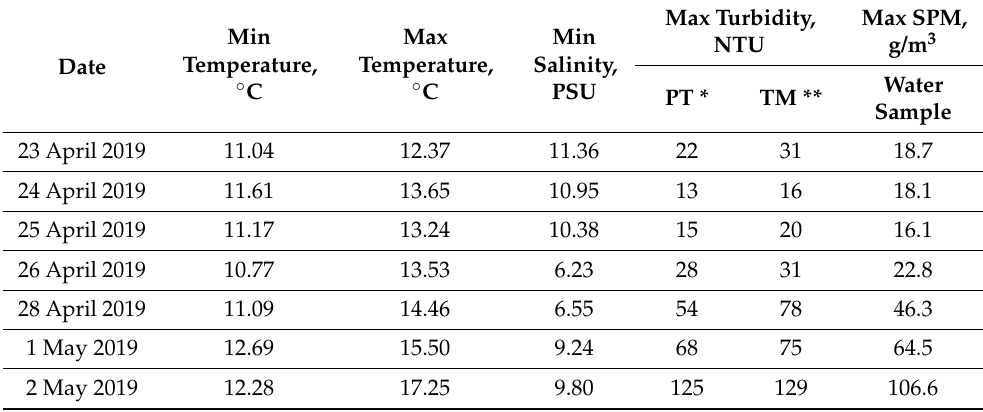
Table 3. Maximum and minimum values of temperature, salinity, turbidity and suspended particulate matter concentration (SPM) in the surface water layer on days of boat